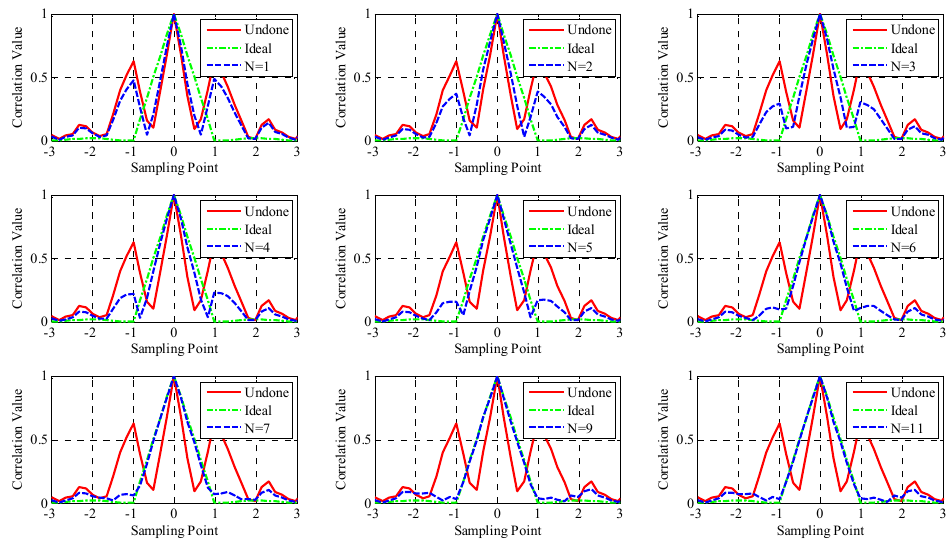
Figure 13. Comparison of sidelobes suppression effects under different reconstructed numbers.